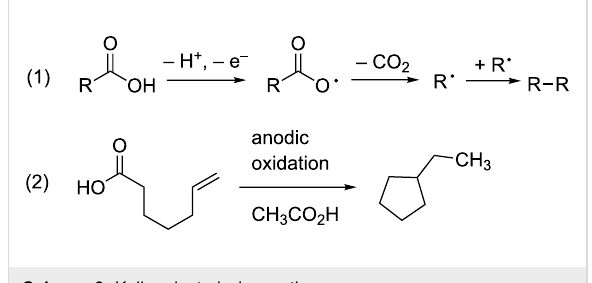
Scheme 3: Kolbe electrolysis